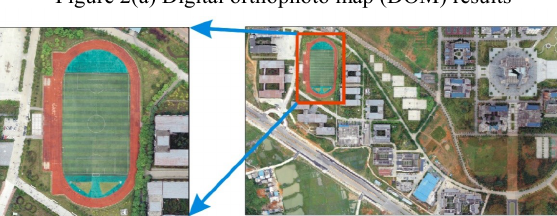
Figure 2(b) Local Digital Orthographic Image (DOM) Results